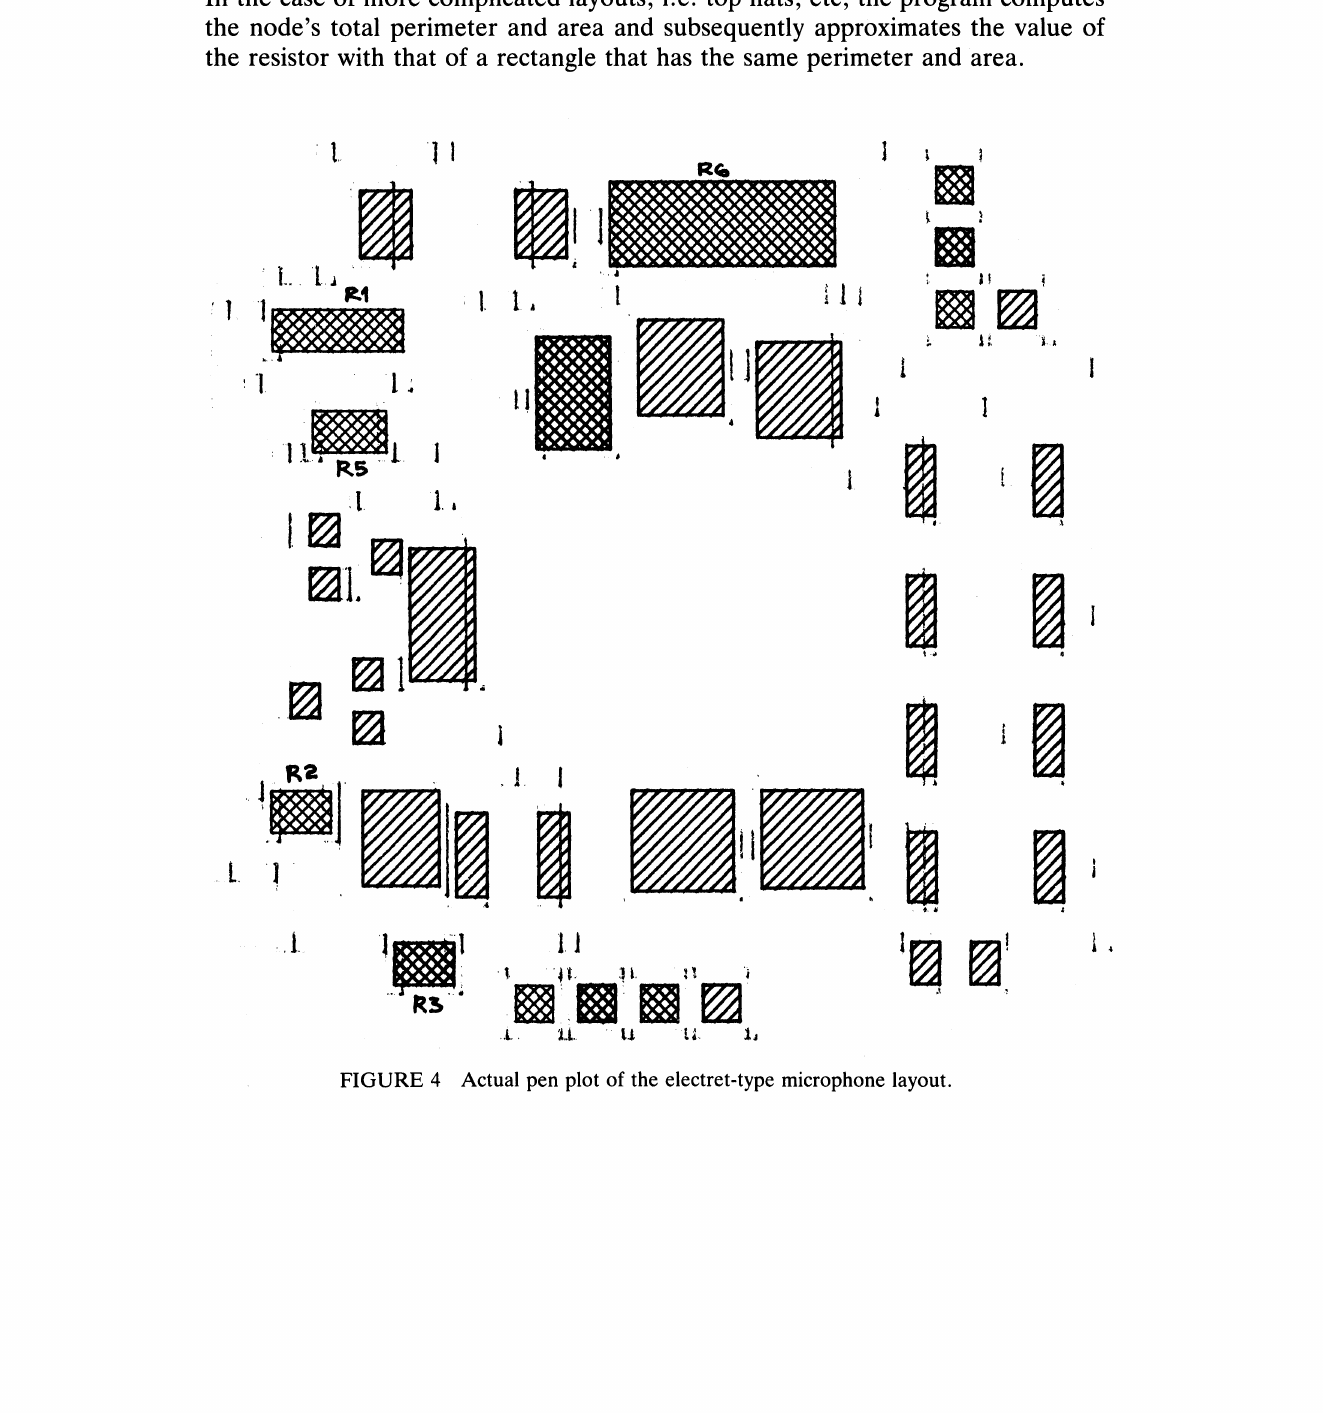
FIGURE 4 Actual pen plot of the electret-type microphone